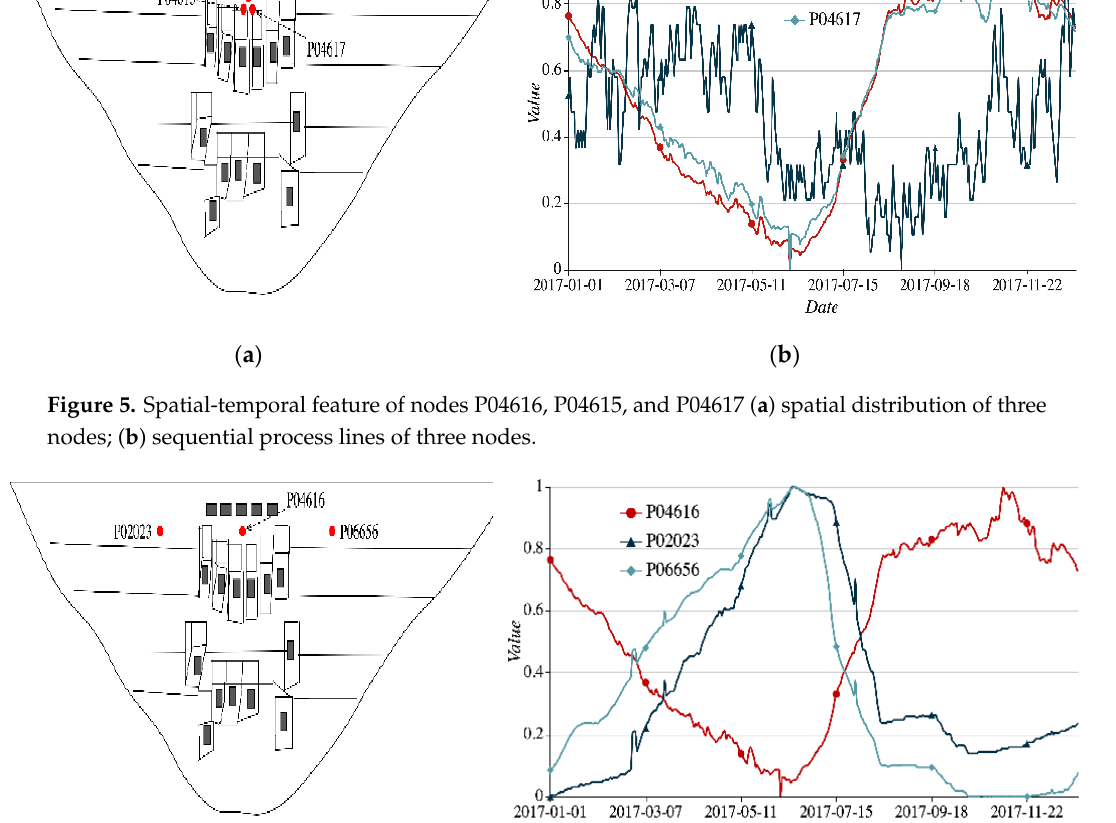
Figure 5. Spatial-temporal feature of nodes P04616, P04615, and P04617 ( a ) spatial distribution of three nodes; ( b ) sequential process lines of three nodes.